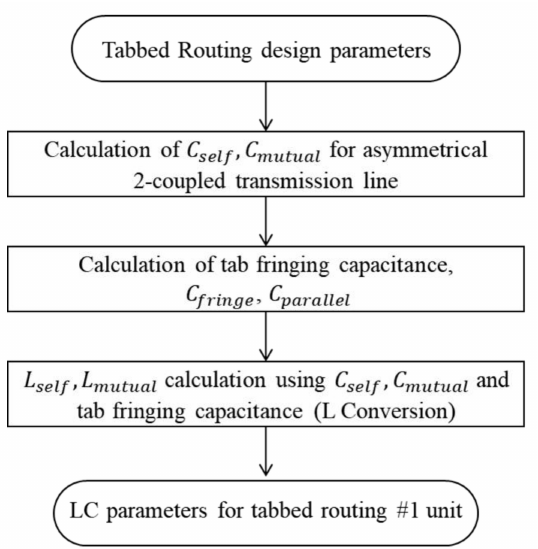
Figure 4. Proposed modeling procedure of tabbed routing is shown as block diagram based on segmentation method.